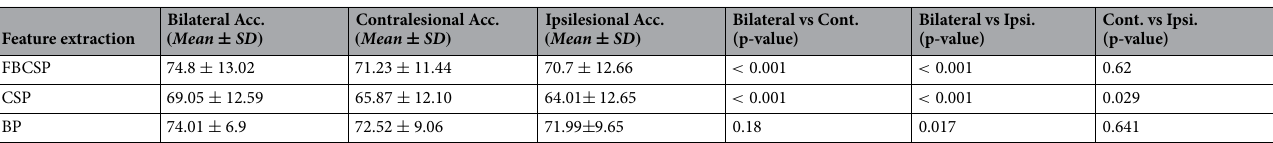
Table 1. Comparison of the average 10 × 10 fold cross-validation BCI accuracies between the three types of BCI (bilateral, contralesional or ipsilesional channels), obtained using three different BCI feature extraction methods. Acc. accuracy, Cont. contralesional, Ipsi. ipsilesional, SD standard deviation, vs versus.